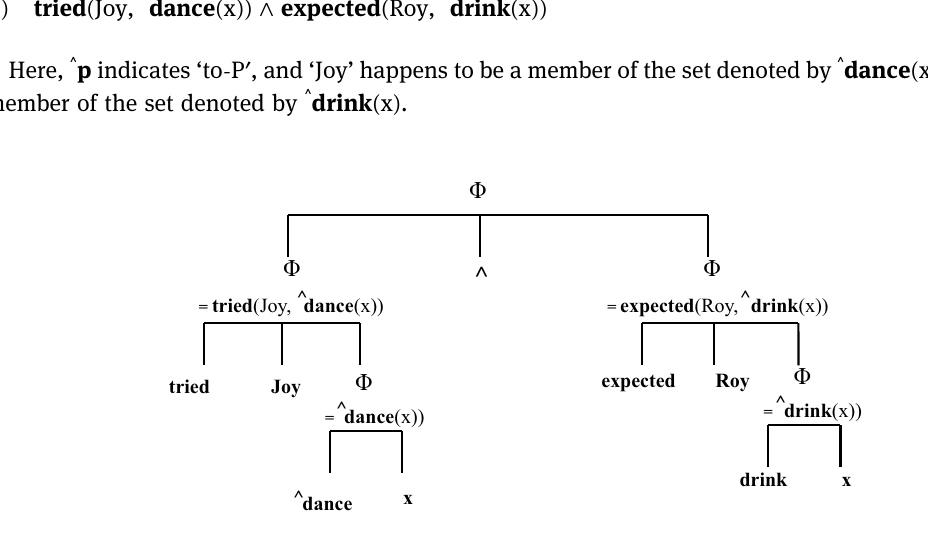
Figure 3: The combinatorial organization of the conceptual functions for ( 40 )